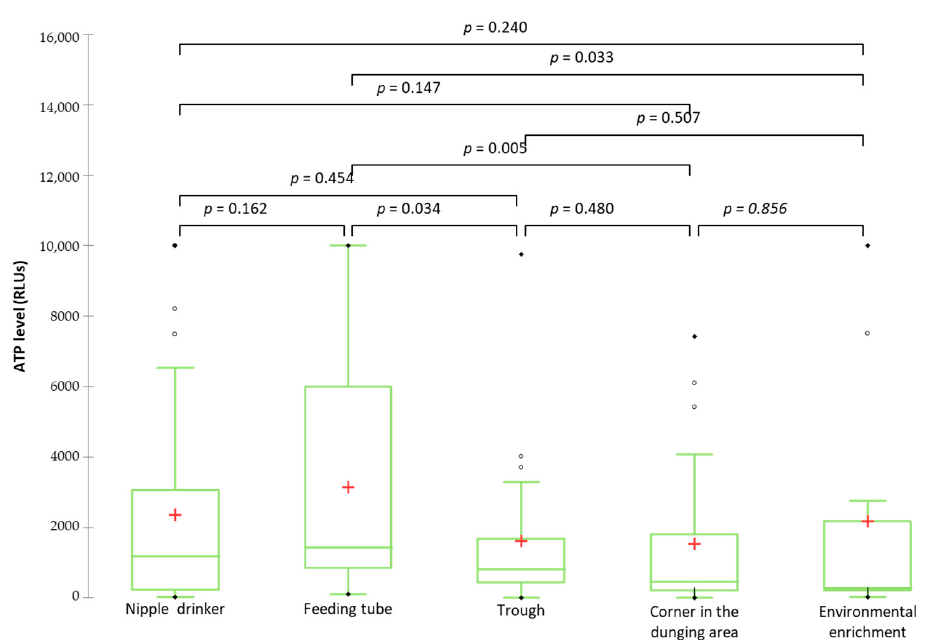
Figure 3. Boxplots of the distribution of ATP levels from environmental swabs for each sampling site in 20 pig farms. In the boxes, the thick horizontal line represents the median biosecurity score, whereas the base and the top of the boxes are the first and third quartiles, respectively. Whiskers extend to a maximum of 1.5 times the interquartile range. Red crosses represent the mean, black dots represent extreme values (maximum and minimum), and hollow circles are the outliers.